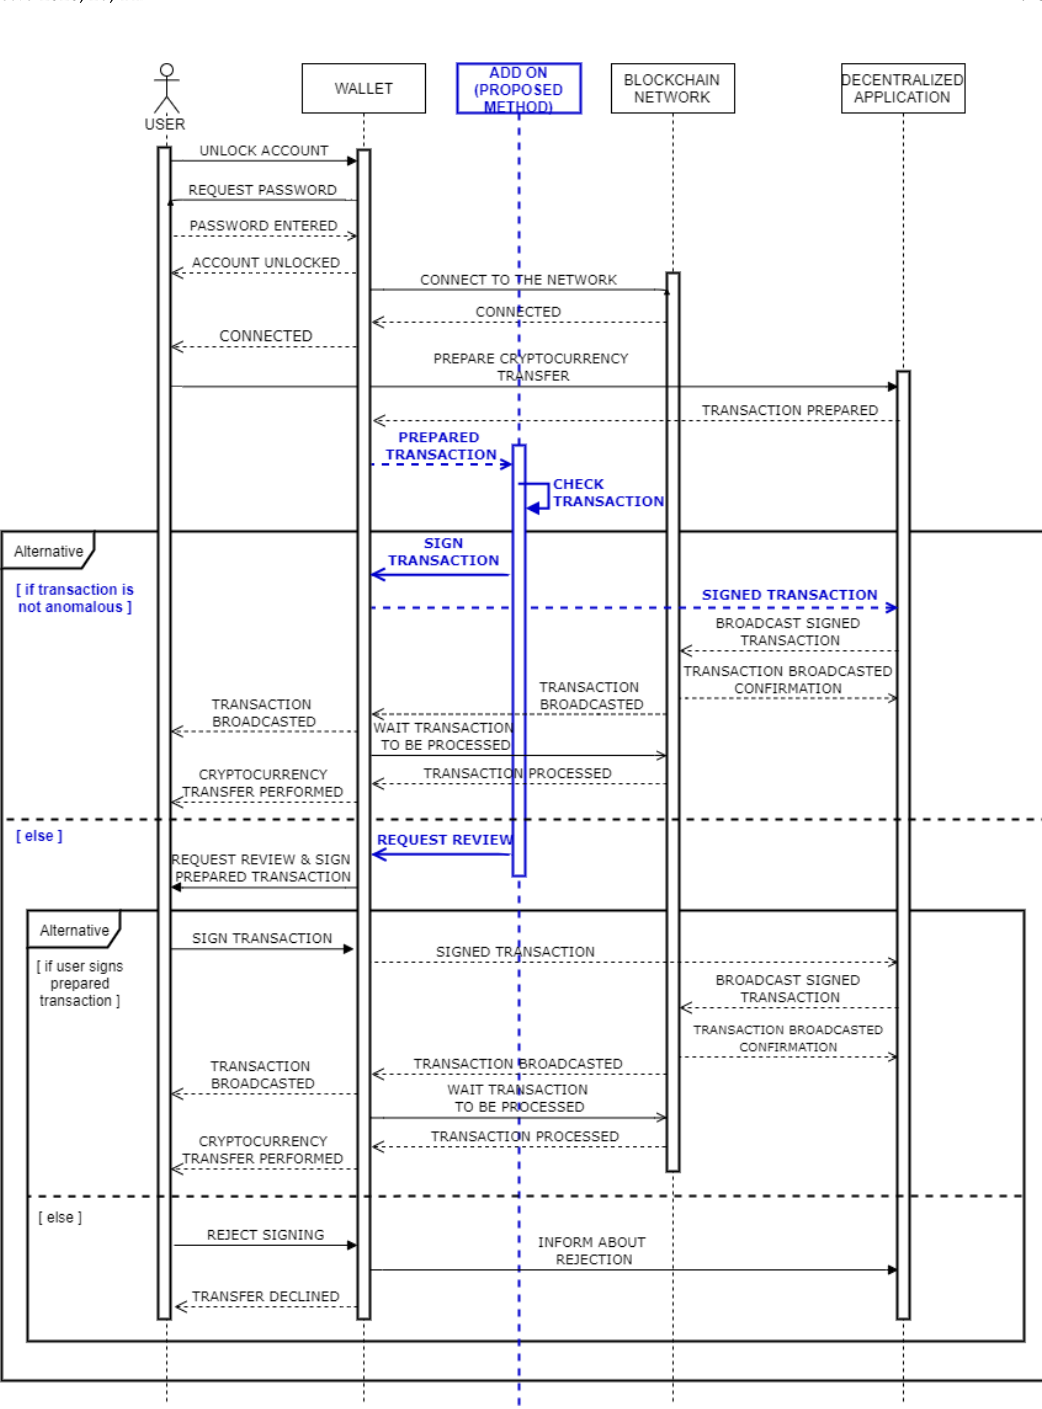
Figure 3. Transaction processing including the proposed